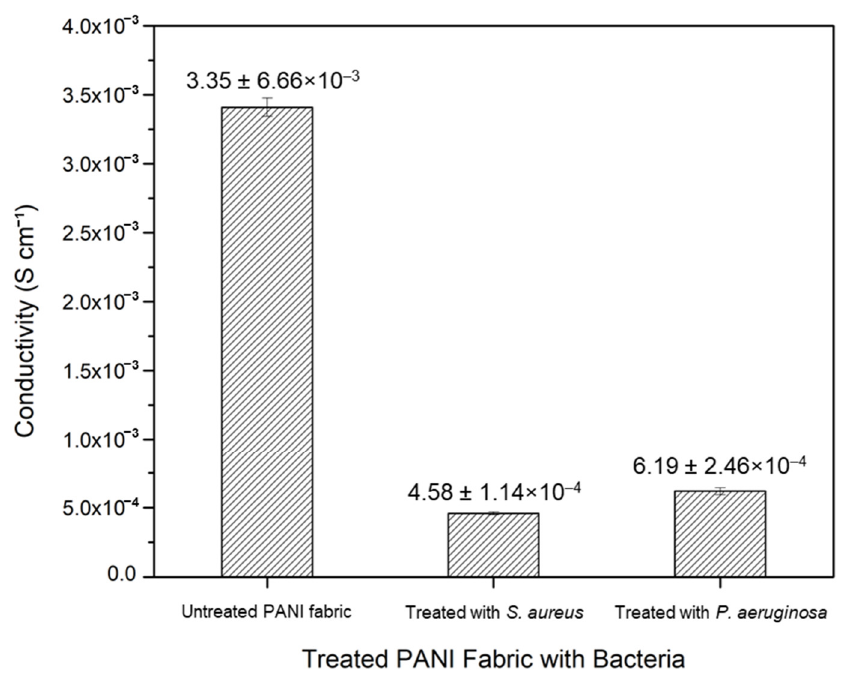
Figure 9. Conductivity values of untreated PANI fabric, and of PANI fabric treated with S. aureus and P. aeruginosa . Error bars indicate the uncertainties of the reported measurements.